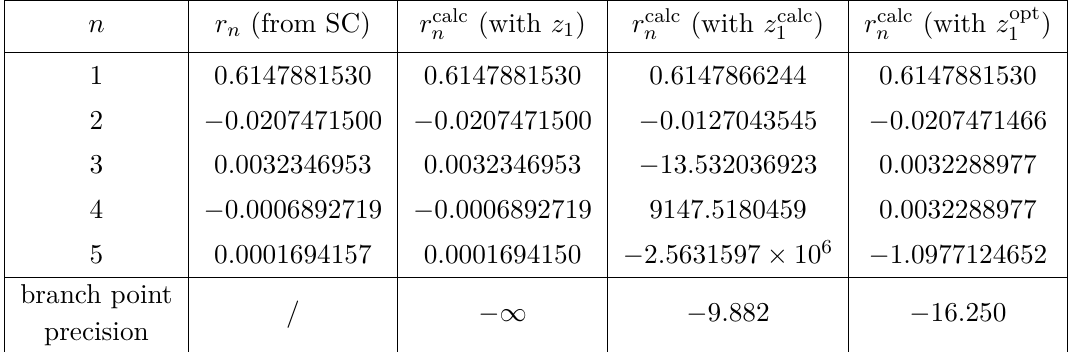
from the Darboux theorem and optimised z opt 1 1 | z calc − z 1 | of the 10 1